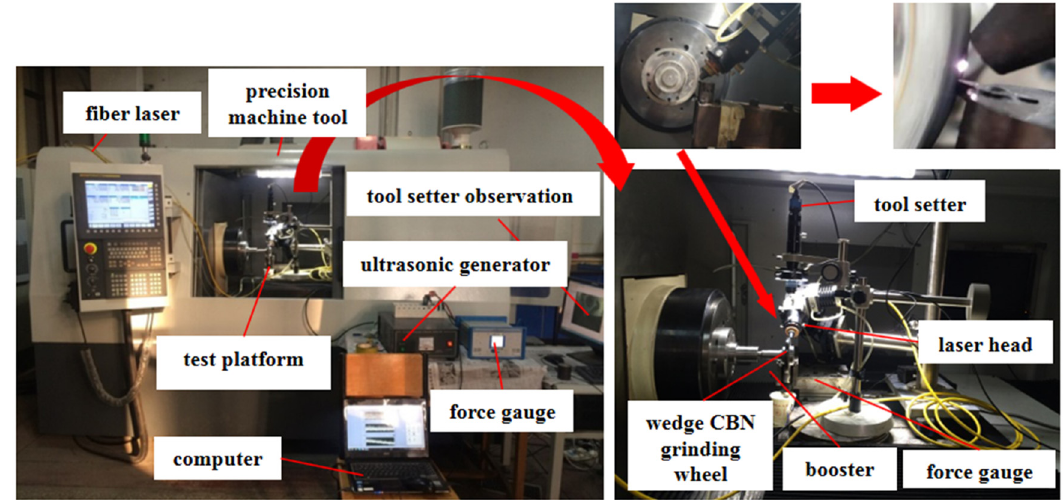
Figure 2: Device of laser - ultrasonic composite dressing of CBN grinding wheel.